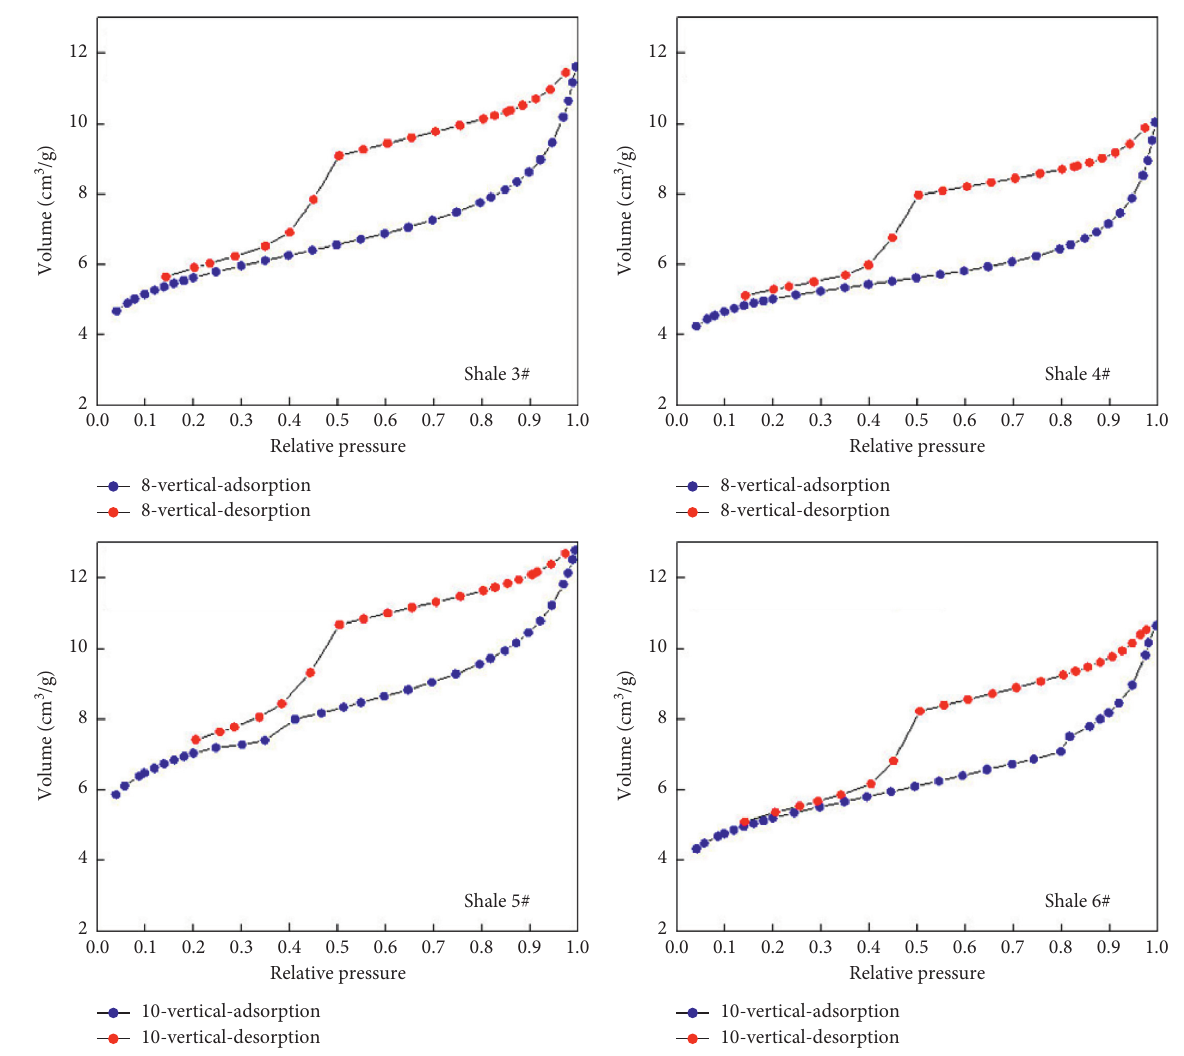
Figure 6: The isotherms of shale 3#, shale 4#, shale 5#, and shale